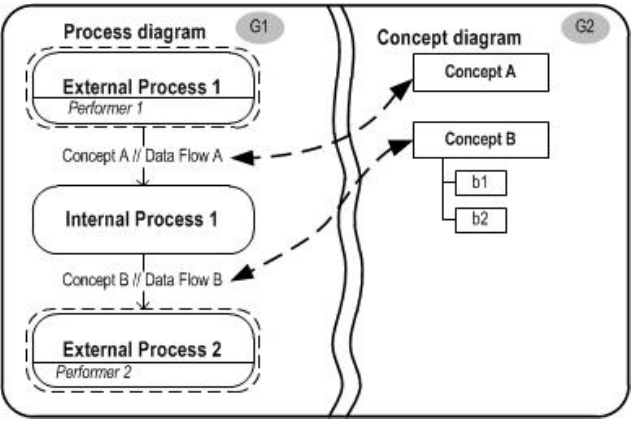
Fig. 1. Notation of the two-hemisphere